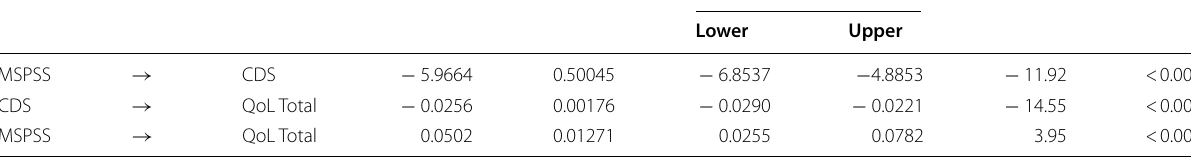
The confidence interval for the indirect effect is a BCa bootstrapped CI based on 5000 samples